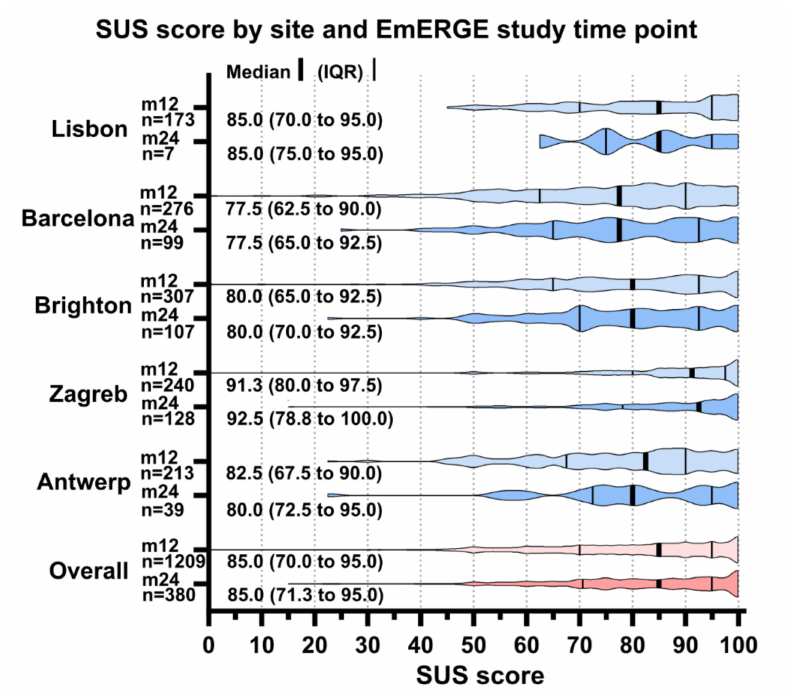
Figure 5. System Usability Score (SUS) score by site and EmERGE study time point. IQR: interquar- tile